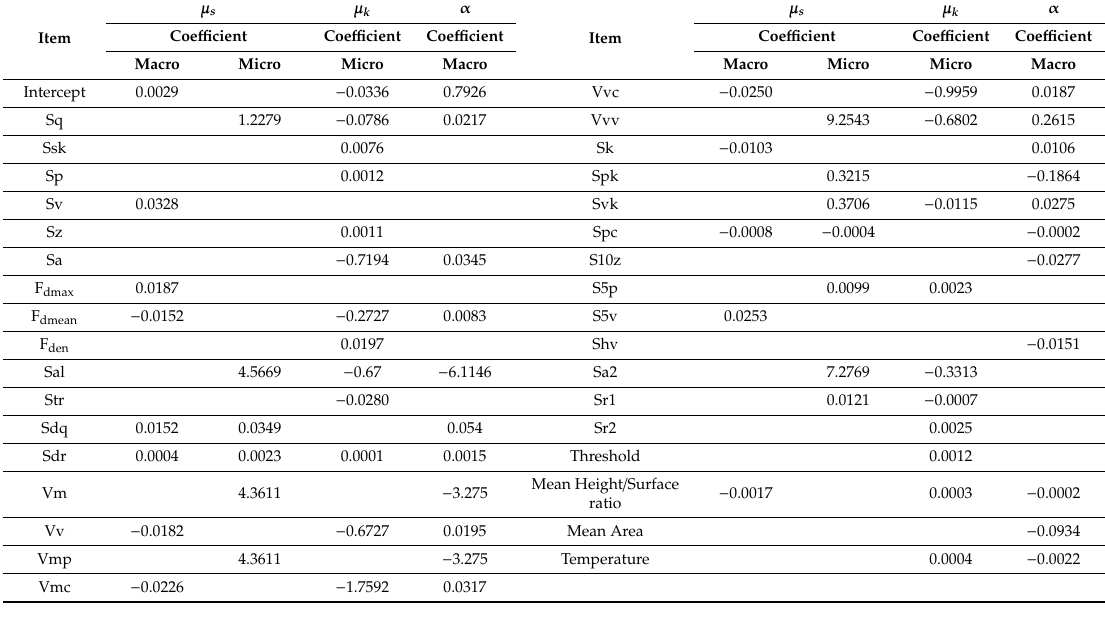
Table 6. PCA Regression coe ffi cients for texture characteristics.